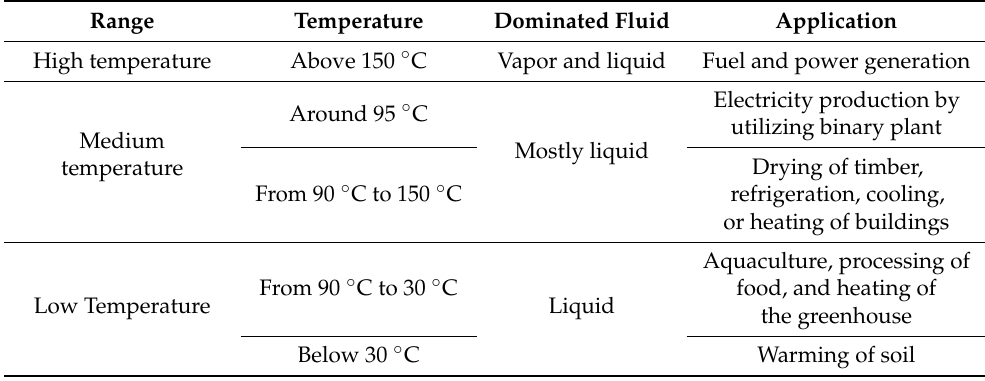
Table 1. Geothermal source temperature and its application [19 – 21].